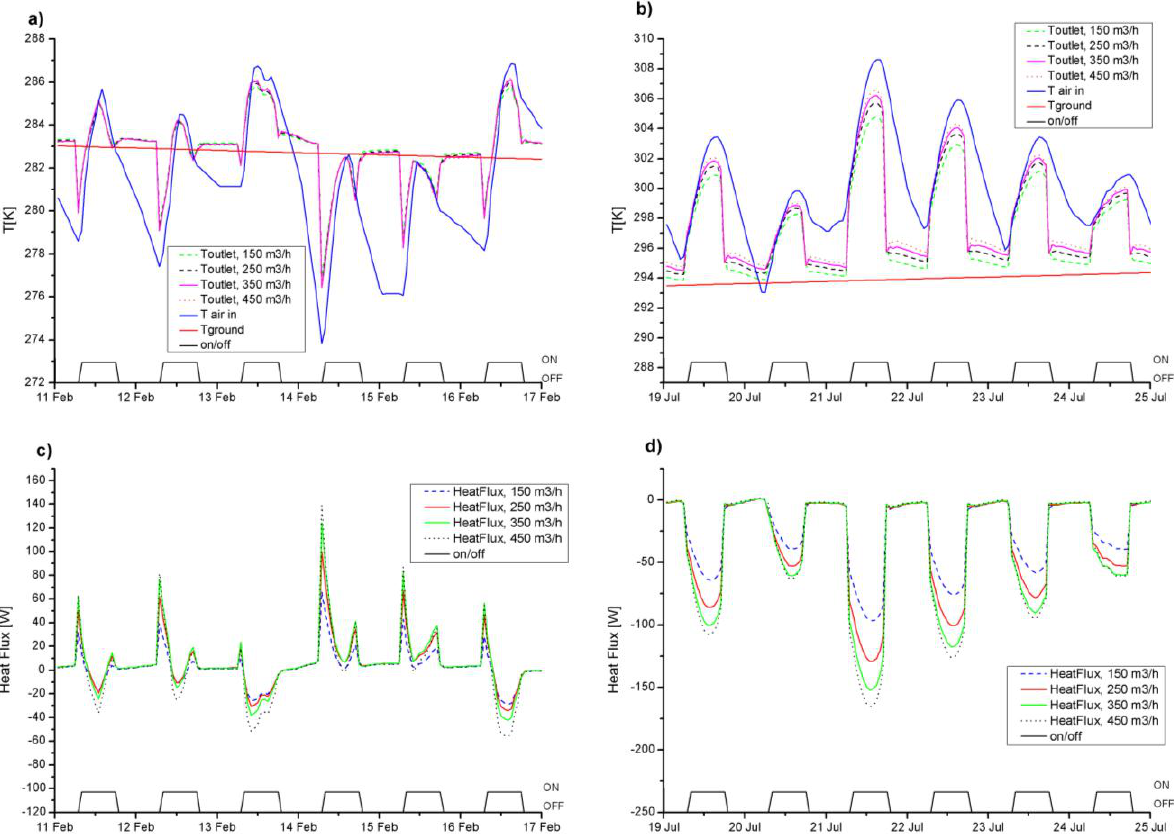
Figure 14. Ground and inlet-outlet air temperatures with λ = 3 W/m K, air-ground thermal power varying the air flow rate (range 150–450 m 3 per hour), for typical winter ( a , c ) and summer weeks ( b , d